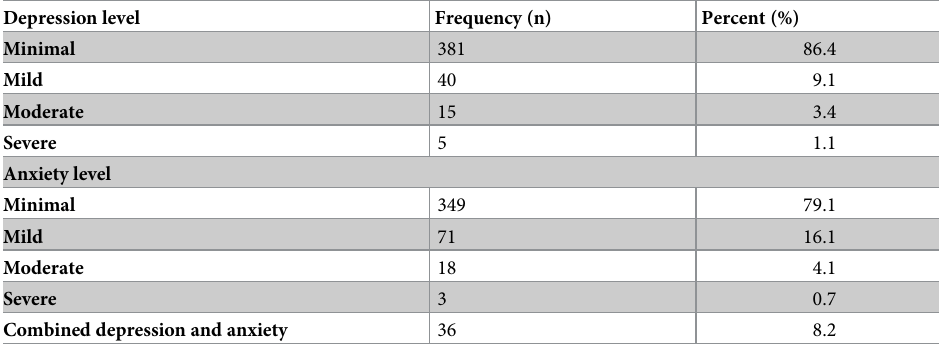
Table 2. Status of depression and anxiety level (n = 441).